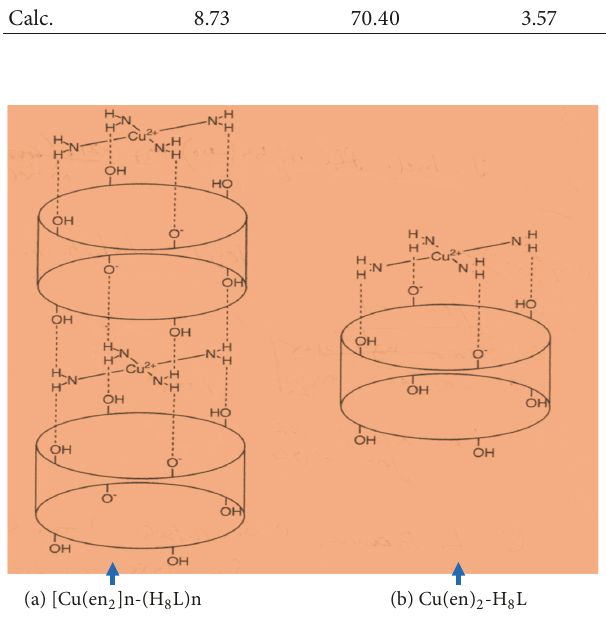
(a) [Cu( ？Ｈ 2 ]n-( （ 8 ， )n (b) Cu (？Ｈ) 2 - （ 8 ， Scheme 1: Structure of Cu(en) 2 -H 8 L